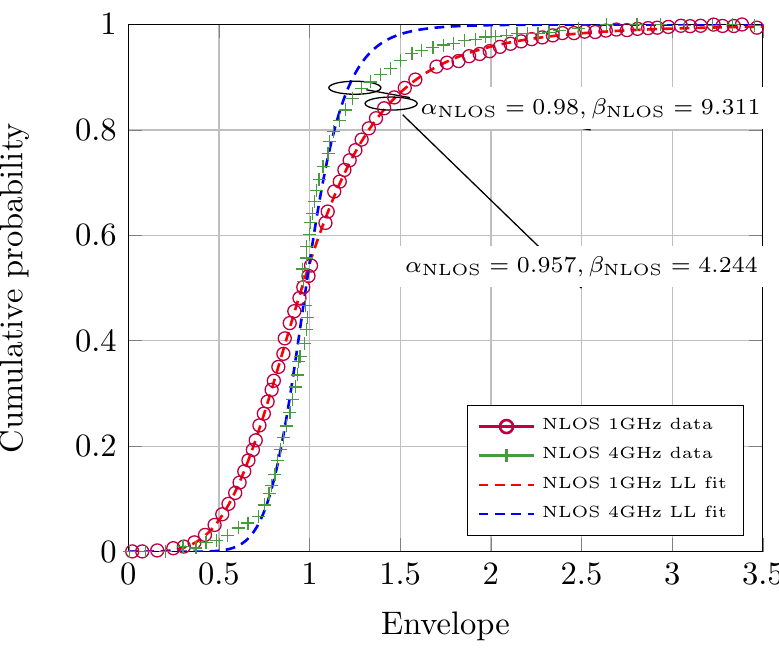
Figure 6. Statistical distributions of fast fading in UAV air-to-ground channels at 1 and 4 GHz, NLOS scenario. Empirical CDF values were obtained from [15], whereas corrected fitting values for the LL distribution are provided here. Goodness-of-fit values are RMSE 1GHz = 4.61 × 10 − 3 and RMSE 4GHz = 3.71 × 10 − 2